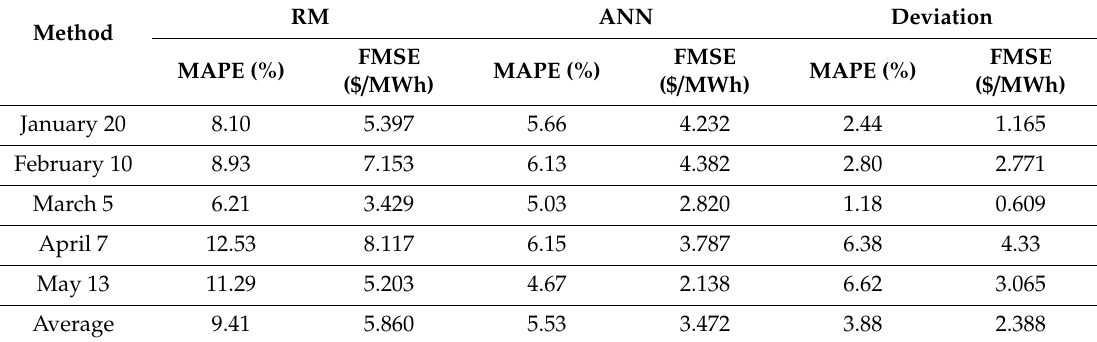
Table 6. Regression model and neural network forecast price to MAPE and